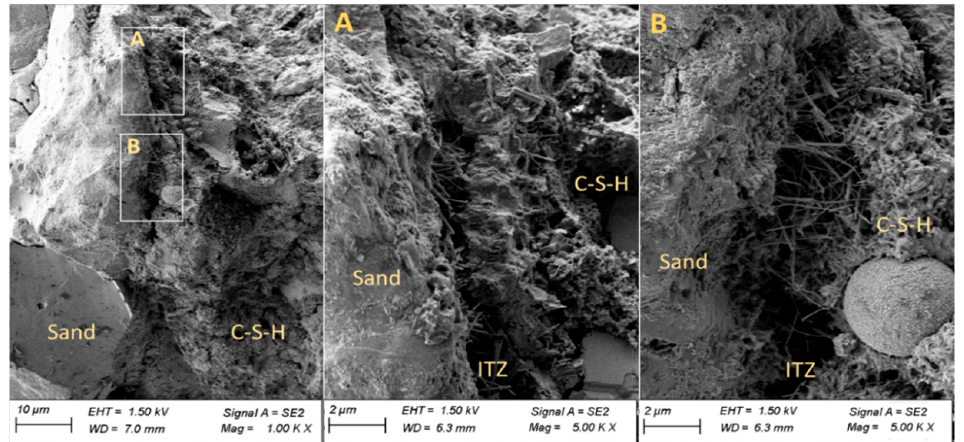
Figure 9. FESEM of the control mix containing FA. Due to the observed gap in the ITZ, points A and B were selected to be focused on.